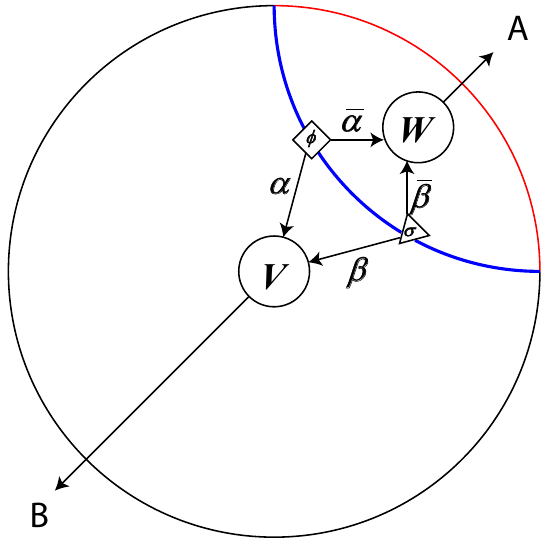
Figure 3 . The graphical representation of the OSED procedure for a holographic bipartite state. By iterating this procedure on a holographic state inductively, one can construct a tensor network for the